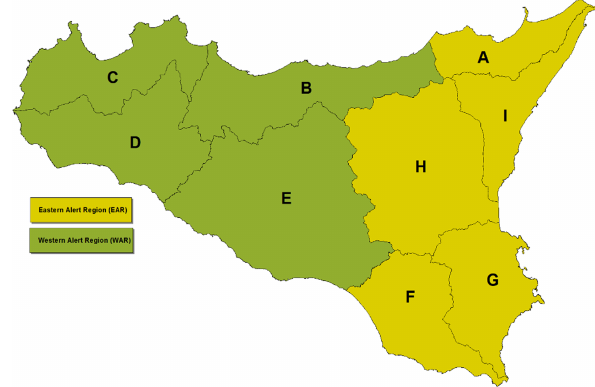
Figure 5. Layout of the procedure for deriving rainfall thresholds for floods. Figure 6. Alert Regions for landslide warning (as proposed by Gar- iano et al.,